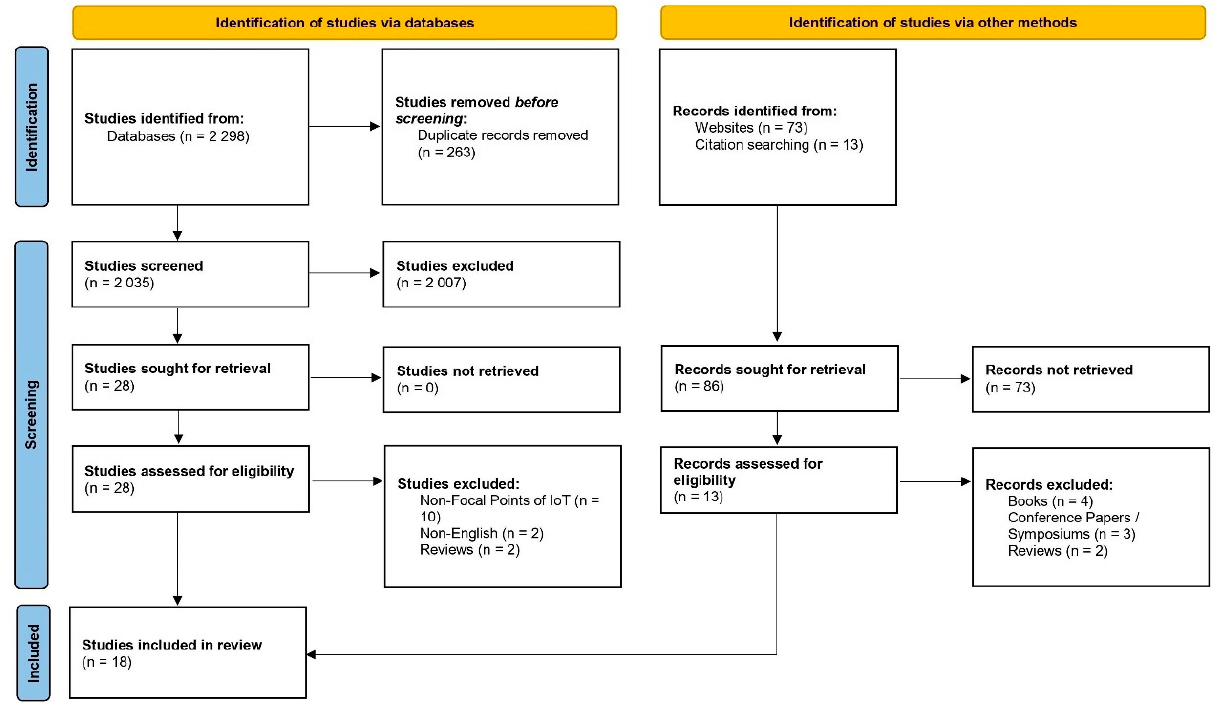
Figure 3. PRISMA Figure 3. PRISMA flowchart.